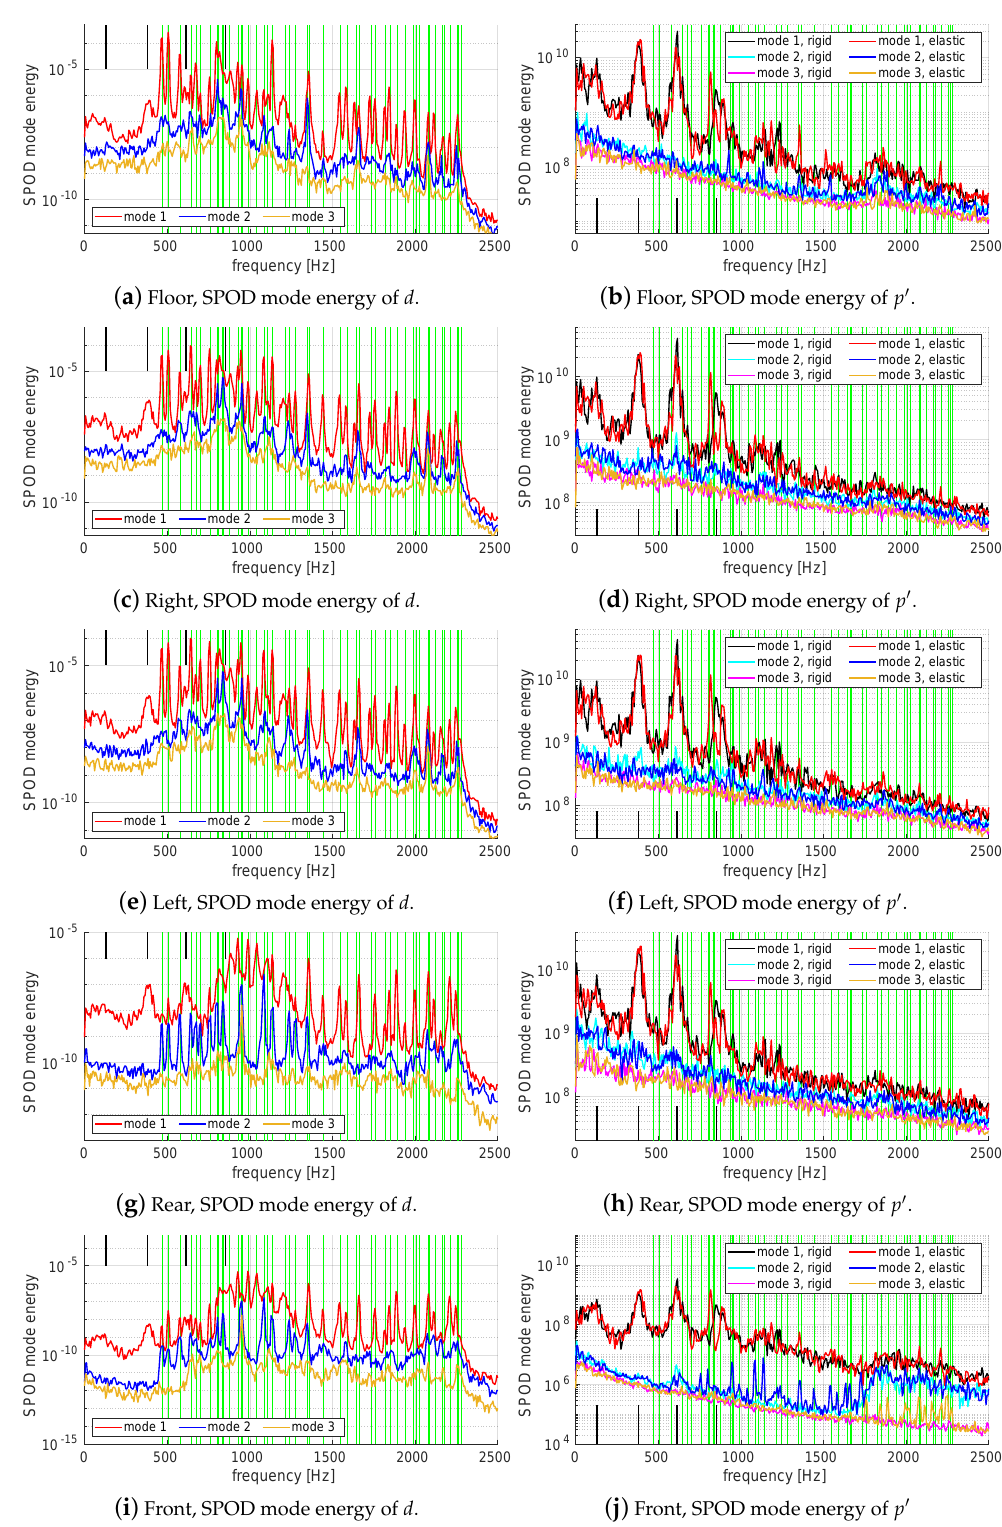
Figure 17. SPOD mode energy for displacements d ( left column ) and pressure fluctuations p (cid:48) ( right column ). Green vertical lines mark the structural eigenfrequencies. Black vertical lines mark the Rossiter